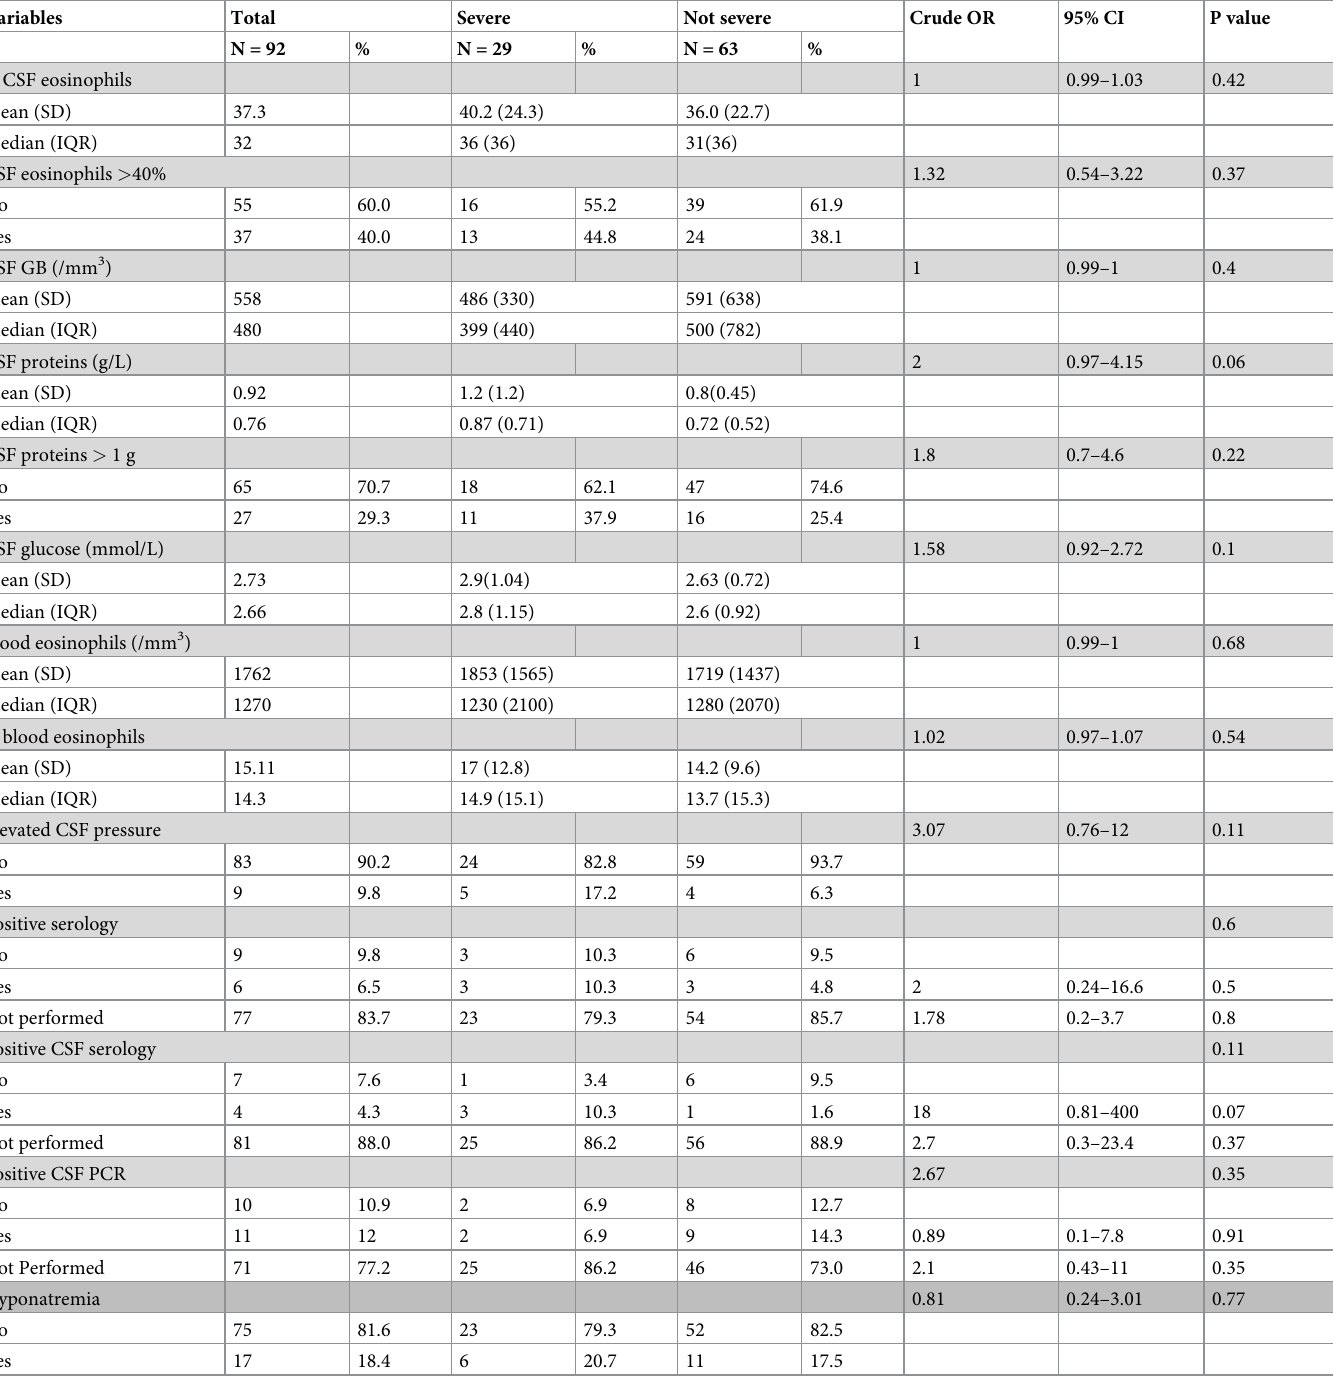
Table 3. Biological features of the New Caledonian cases of EM from 2004 to 2019 according to severity, n = 92.